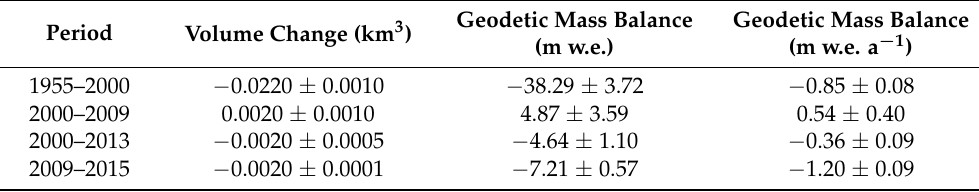
Table 3. Summary of volume changes and geodetic mass balances for each observation period. We assumed an ice density of 850 kg m ‐ 3 .